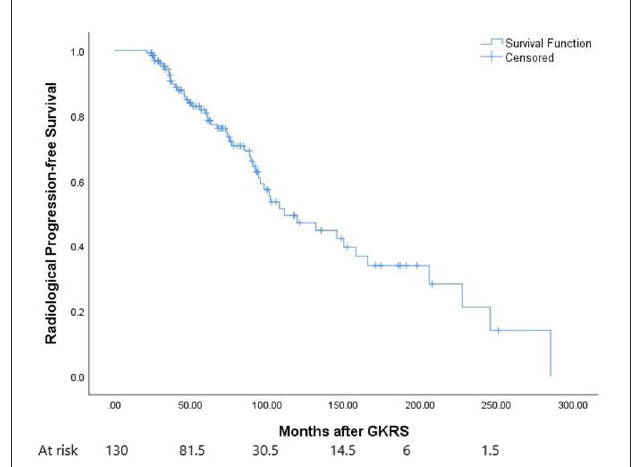
FIGURE1 The Kaplan–Meier curve of radiological progression-free survival (PFS) in the entire series. The PFS was 100, 90, 78, and 47% at 1, 3, 5, and 10 years, respectively.